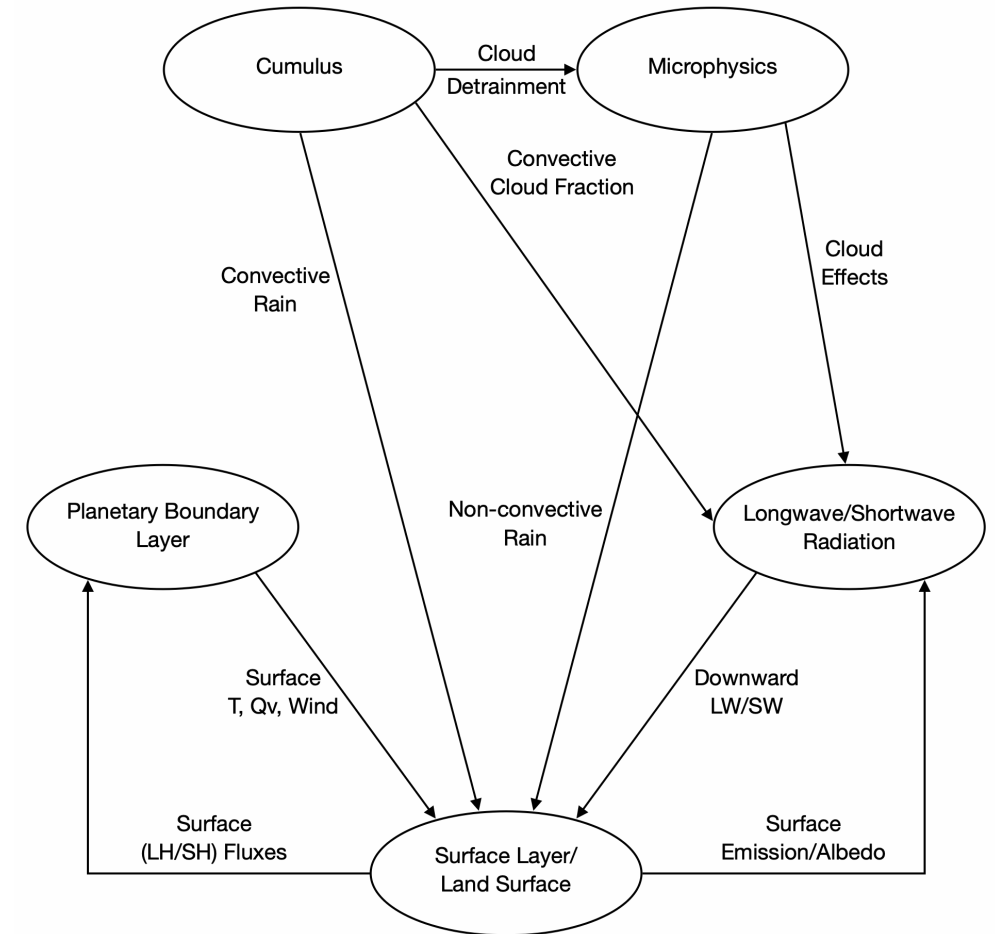
Figure 2. Direct interactions between the various Weather Research and Forecasting (WRF) physics options